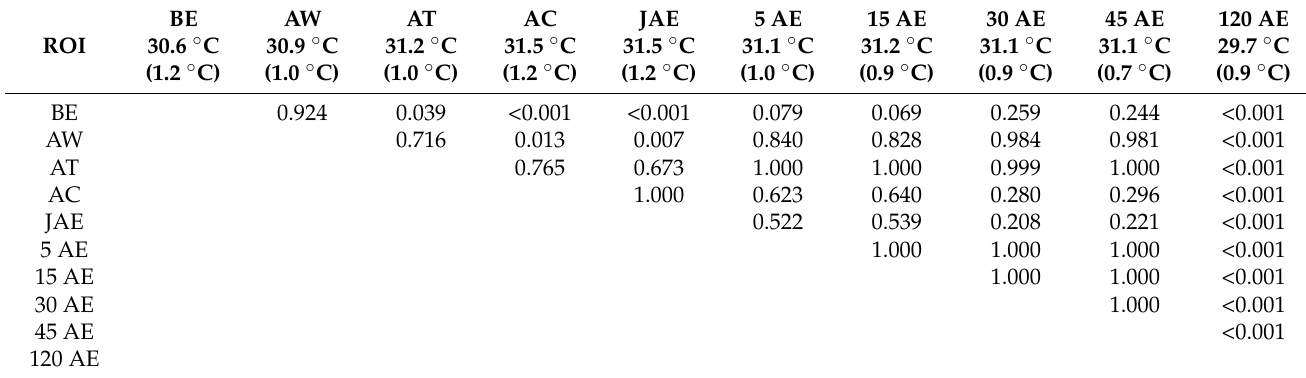
Figure 3. The average temperature (Tavg) of all regions of interest (ROIs) measured before exercise (BE), after walk (AW), after trot (AT), after canter (AC), after second walk (JAE), 5 min after exercise (5 AE), 15 min after exercise (15 AE), 30 min after exercise (30 AE), 45 min after exercise (45 AE), and 120 min after exercise (120 AE) in nine dogs. Compared with BE, multiple comparisons indicated a statistically significant increase in body surface temperature of all ROIs at timepoint AT, persisting until JAE, and returning to the initial temperature level at 5 AE (Table 2). The highest body surface temperatures were at timepoints AC and JAE (31.5 ◦ C). The average body temperature of the dogs before the exercise was 1 ◦ C higher than the temperature after 120 min of recovery time (120 AE) ( p < 0.001). Table 2. The result of multiple comparisons ( p -value) between the temperatures (mean of all ROI) in subsequent stages of the study; significant differences were marked at the level of p < 0.05. BE ROI 30.6 ◦ C BE 0.924 <0.001